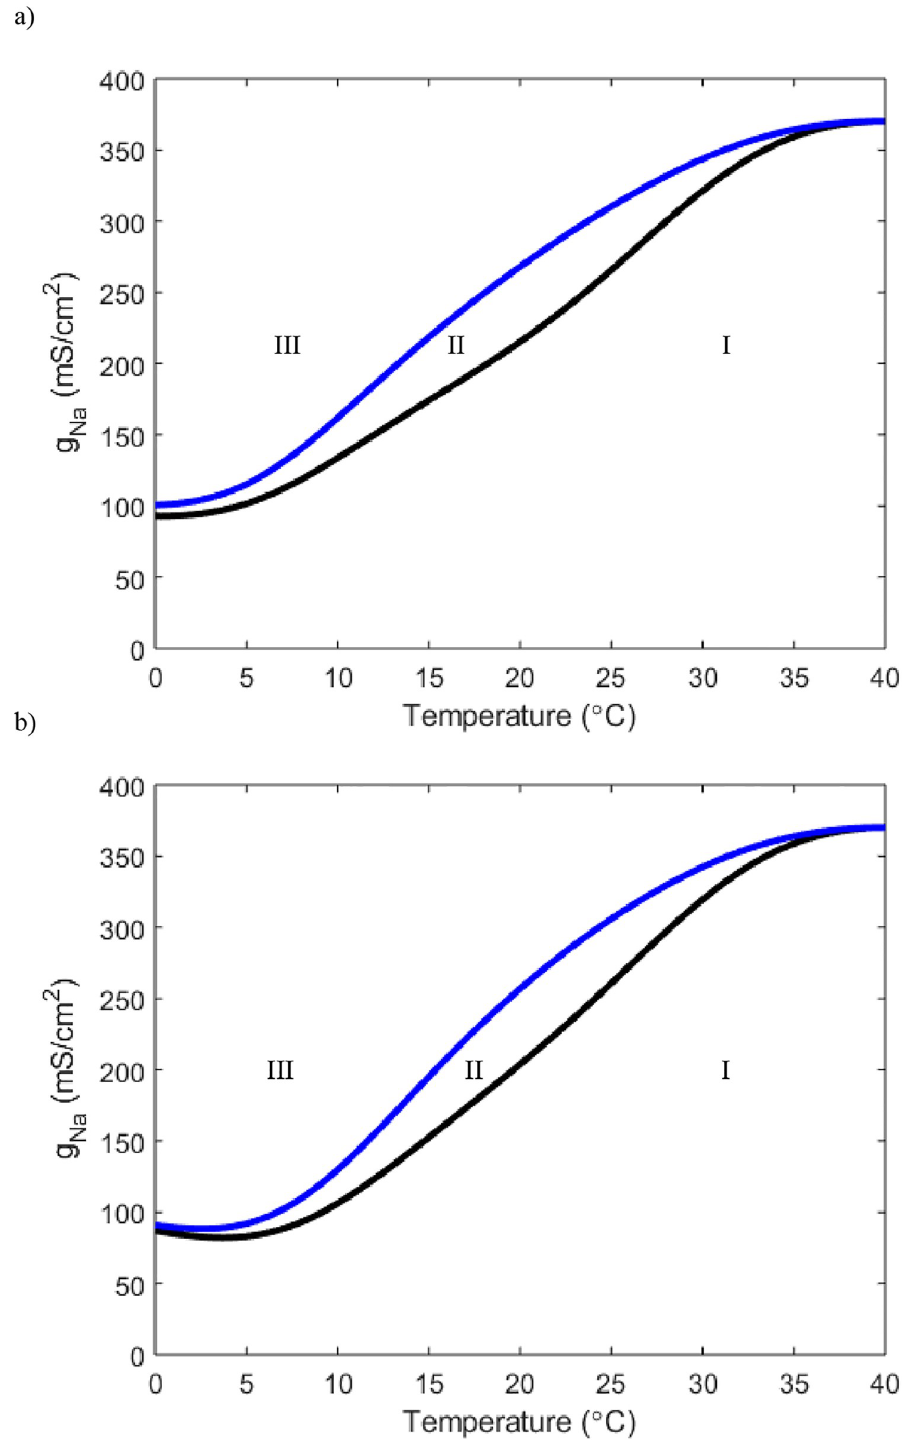
Fig 13. Two parameter bifurcations showing the relationship between temperature and g Na . In the top plot g m 8 = .5 and in the bottom g m 8 = 1. Both g l and g K are set to Hodgkin-Huxley values. Curve color and region meaning is equivalent to other two parameter bifurcation plots.